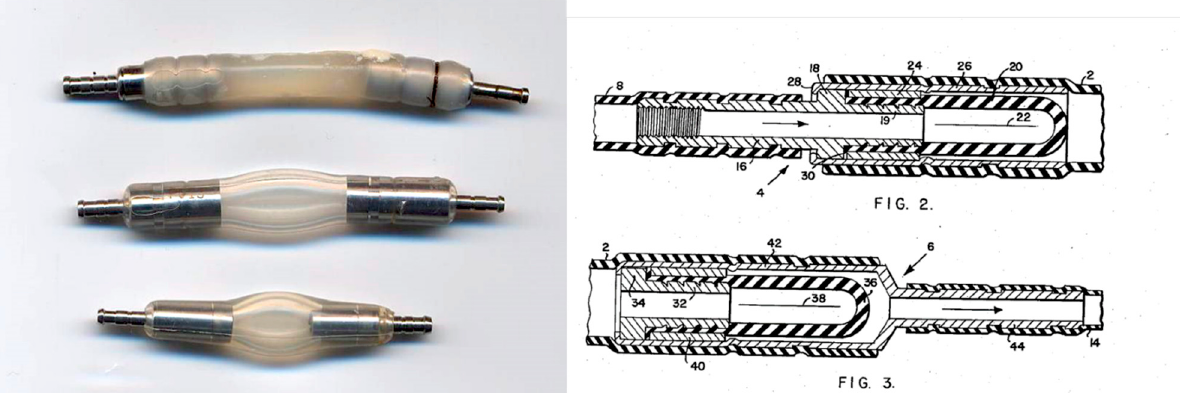
Figure 1. ( Left ). Reproduced with permission from A. Aschoff. Three different Holter valve designs are shown. The first valve on top is the oldest model (circa 1970), more recent designs in the middle and on the bottom. This valve was discontinued and no longer available. ( Right ). Reproduced from Figures 2 and 3 of the patent filed 2 October 1956 by Holter and Spitz [12]. Both figures are enlarged sections showing the inlet (FIG. 2) and outlet valves (FIG. 3) of the device. Labels 22 and 38 show the inlet and outlet tubes with lateral slits “three-sixteenth inch in length” (0.80 cm), which functions as the actual valve.